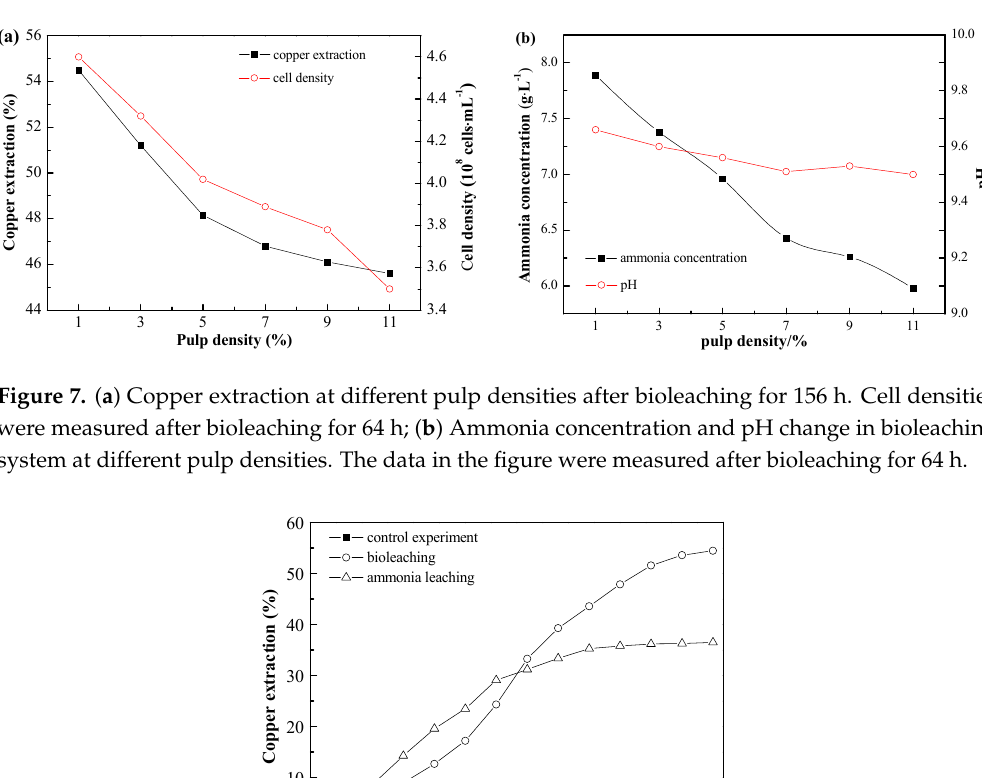
Table 2. Phase composition of copper ore before and after bioleaching at the pulp density of 1% and copper extraction (%) after 156 h.